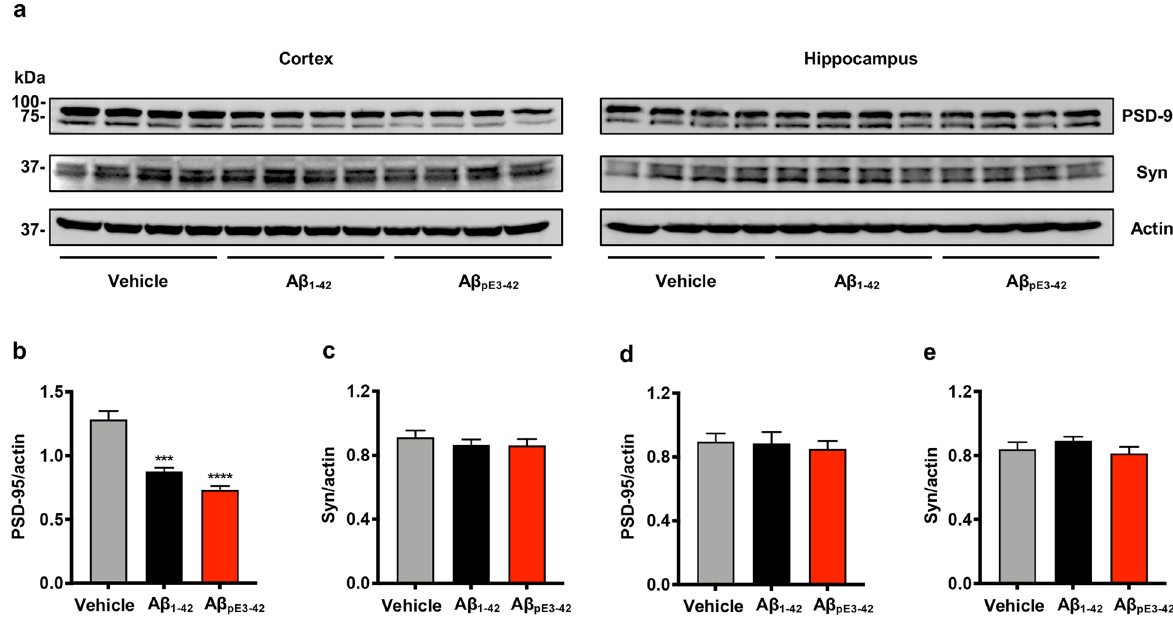
Figure 5. Aβ pE3-42 -induced down-regulation of postsynaptic protein level in cortical lysate. ( a ) Western blot analysis of PSD-95 (85 kDa), synaptophysin (40 kDa), and β-actin (38 KDa) expression in hippocampal and cortical lysates of vehicles, Aβ 1-42 -infused mouse models, and Aβ pE3-42 -infused mouse models. The original and uncropped full-membrane results with PSD-95, synaptophysin, and actin are presented in Supplementary